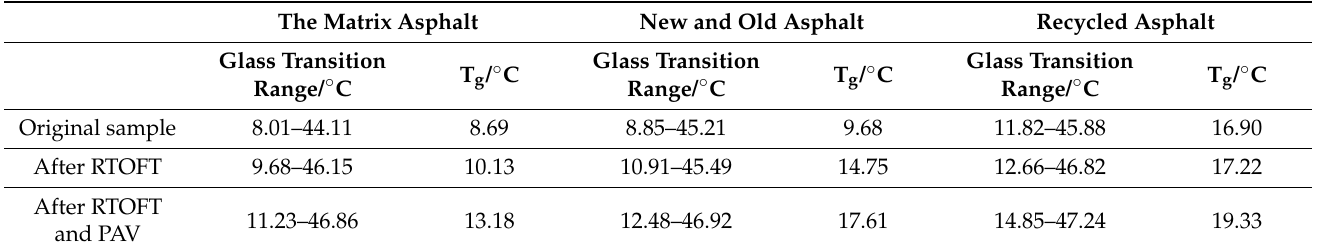
Table 5. Glass transition range and glass transition temperature of three asphalts before and after